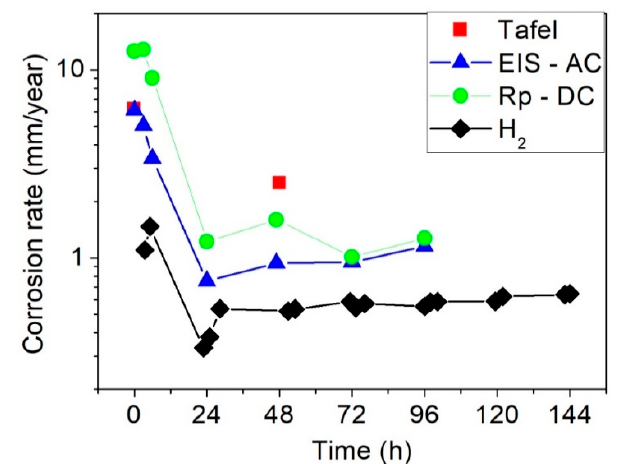
Figure 12. Comparison of corrosion rates from different testing techniques in EZ51-IM350 alloy immersed in PBS solution. Please note that hydrogen release corresponds to accumulated rate while electrochemical techniques are instantaneous rates.